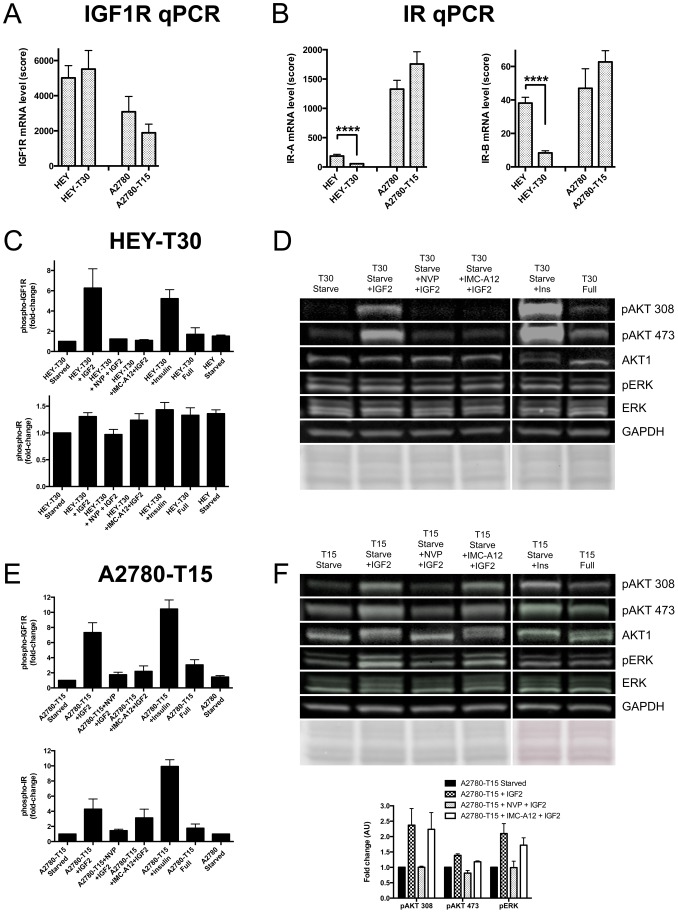
Effects of ligand stimulation and targeted therapeutics on IGF1R and IR expression and phosphorylation.(A) IGF1R mRNA of sensitive and resistant cell lines. Measured by RT-qPCR (n = 5 independent experiments each done in triplicate), IGF1R mRNA levels are similar when resistant cell lines are compared to their parental cell lines of origin. Bars show the mean±SEM. (B) IR mRNA of sensitive and resistant cell lines. Measured by RT-qPCR (n = 5 independent experiments each done in triplicate) IR-A and IR-B mRNA levels in HEY-T30 are significantly decreased when compared to HEY, while similar levels are observed when comparing A2780-T15 to A2780. Bars show the mean±SEM, ****p<0.0001; unpaired t-test. (C) Phospho-IGF1R and phospho-IR ELISA in HEY-T30. Cells were starved overnight, incubated with 1 µM NVP-AEW541 or 10 µg/ml IMC-A12 for 2 hours, stimulated with 50 ng/ml IGF2 or 50 nM insulin for 10 minutes, lysed, and levels of phosphorylated IGF1R and IR determined by ELISA. Both IGF2 and insulin caused 5- to 6-fold-change increased levels of phospho-IGF1R that could be suppressed by NVP-AEW541 or IMC-A12. The changes in phospho-IR after stimulation with IGF2 or insulin were much smaller (fold-change <1.5). Bars depict mean±SEM fold-change phosphorylation levels of at least two independent experiments, each done in duplicate. (D) Phospho-AKT and phospho-ERK Western blot. Cell lysates prepared as described in (C) were used for immunoblotting using phosphorylation-specific AKT and ERK antibodies. IGF2-induced AKT phosphorylation at threonine 308 and serine 473 was suppressed by NVP-AEW541 and IMC-A12, while total AKT was unchanged. No effect was seen on phospho-ERK levels. One representative experiment of two independent experiments is shown. Equal protein loading was confirmed by Ponceau staining and GAPDH immunoblotting. (E) Phospho-IGF1R and phospho-IR ELISA in A2780-T15. Cells were prepared similarly to (C). IGF2 and insulin caused 7-fold and 10-fold increased levels of phospho-IGF1R, respectively, and this could be suppressed by NVP-AEW541 or IMC-A12. Levels of phospho-IR after IGF2 or insulin stimulation also increased, 4-fold and 9-fold, respectively. Suppression of phospho-IR with NVP-AEW541 was more effective than with IMC-A12, at these concentrations. Bars depict mean fold-change phosphorylation levels±SEM of at least two independent experiments, each done in duplicate. (F) Phospho-AKT and phospho-ERK Western blot. IGF2-induced AKT and ERK phosphorylation was suppressed by NVP-AEW541 but not by IMC-A12. One representative experiment of two independent experiments is shown. Quantitation by densitometry is shown in the accompanying graph, where bars depict the mean expression±SEM (from two independent experiments) of each of the indicated phospho-proteins, normalized to starved unstimulated cells.